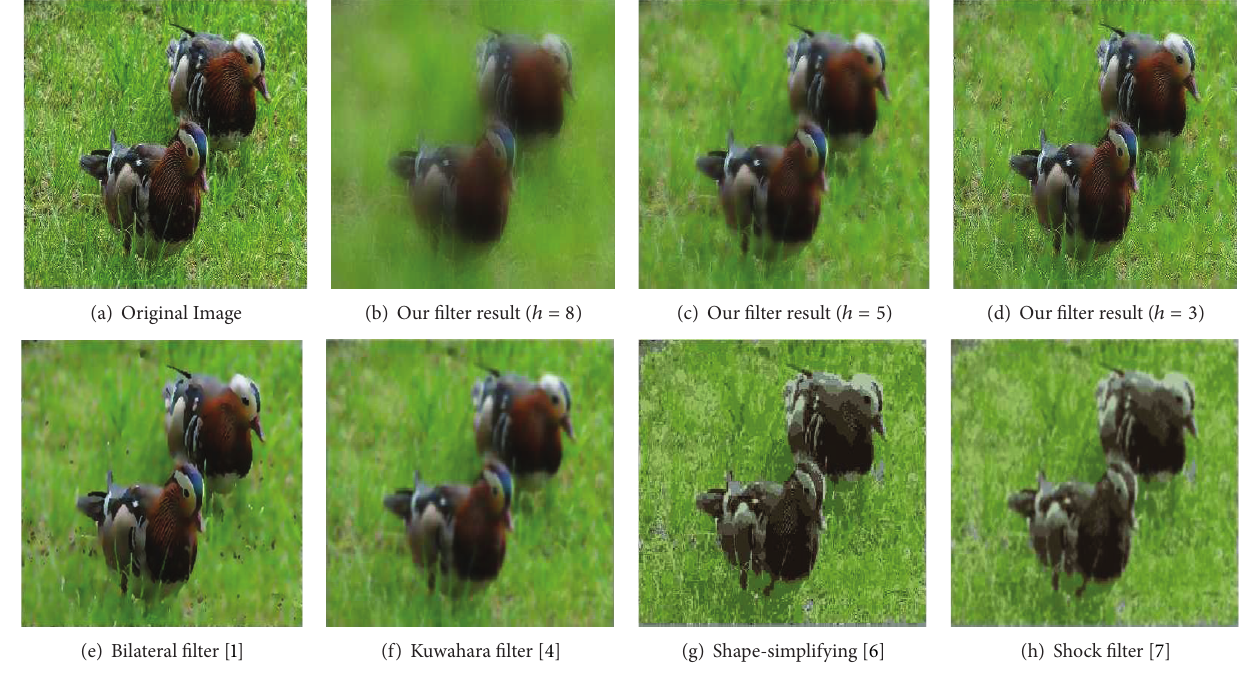
Figure 2: Comparison of different filter.